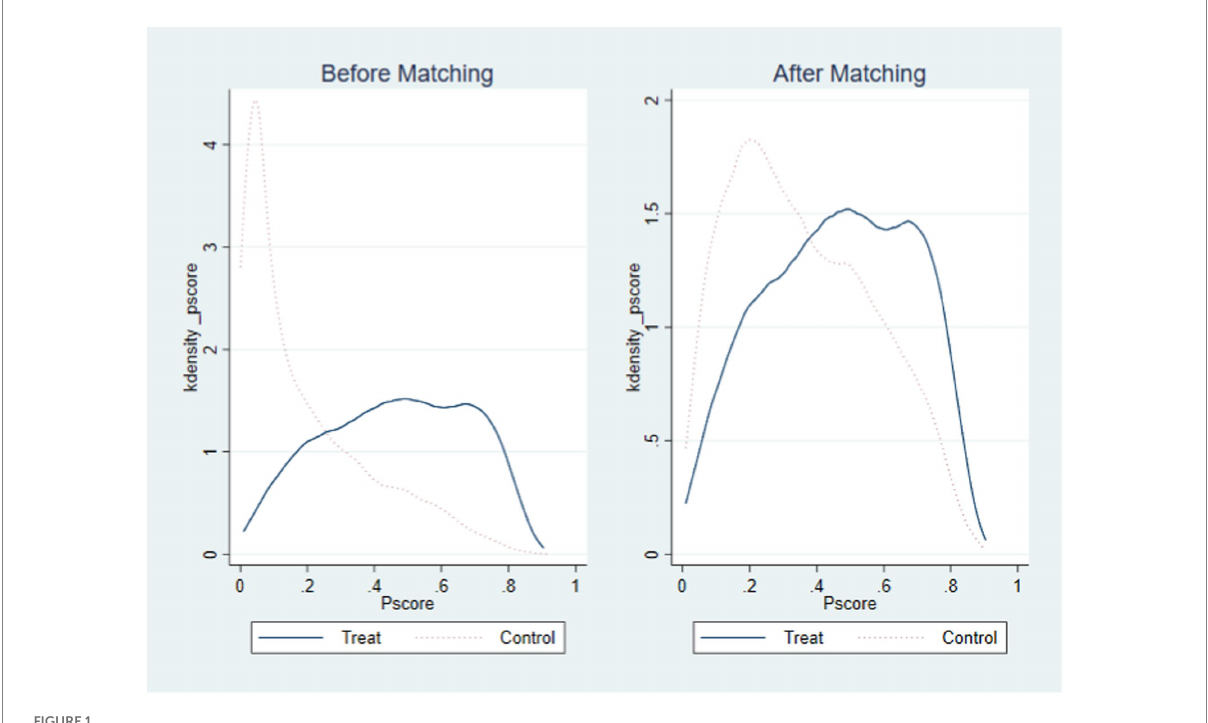
FIGURE 1 Kernel density distribution before and after matching.